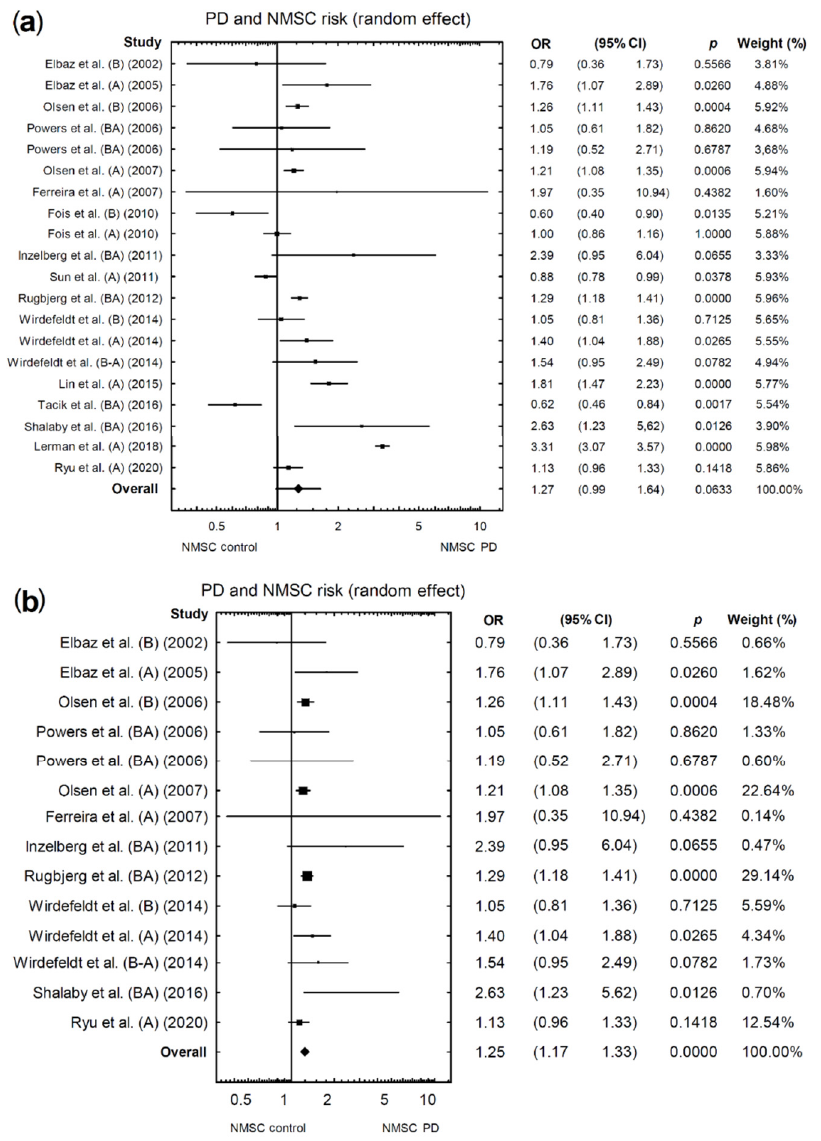
Figure 2. Forest plot of pooled studies of NMSC occurrence in PD patients: ( a ) all studies; ( b ) studies causing high heterogeneity excluded. Each line represents an individual study result, with the width of the horizontal line indicating a 95% confidence interval (CI) and the position of the box representing the point estimate OR (odds ratio) (B—NMSCs before PD diagnosis, A—NMSCs after PD diagnosis, BA—NMSCs diagnosed before or after PD diagnosis, B ‐ A NMSCs diagnosed ±1 year before or after PD diagnosis).